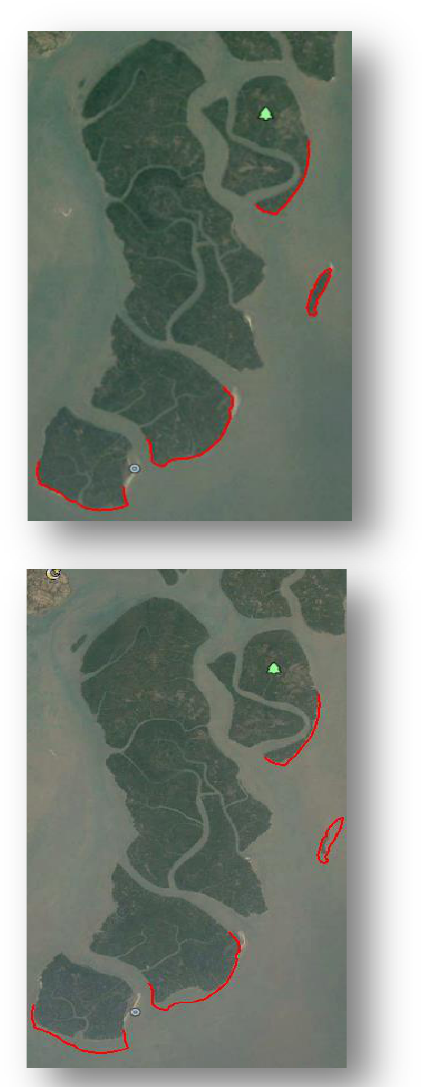
Figure 4: DEM and SLOPE of the study area (Source-ASTER)